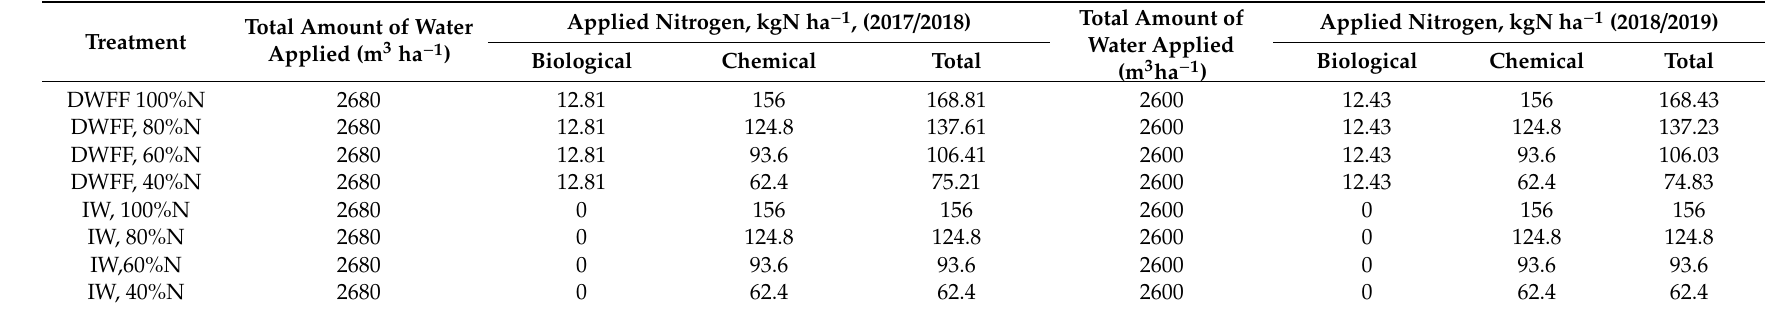
Table 5. Total amount of applied irrigation water and nitrogen for each treatment in the two studied